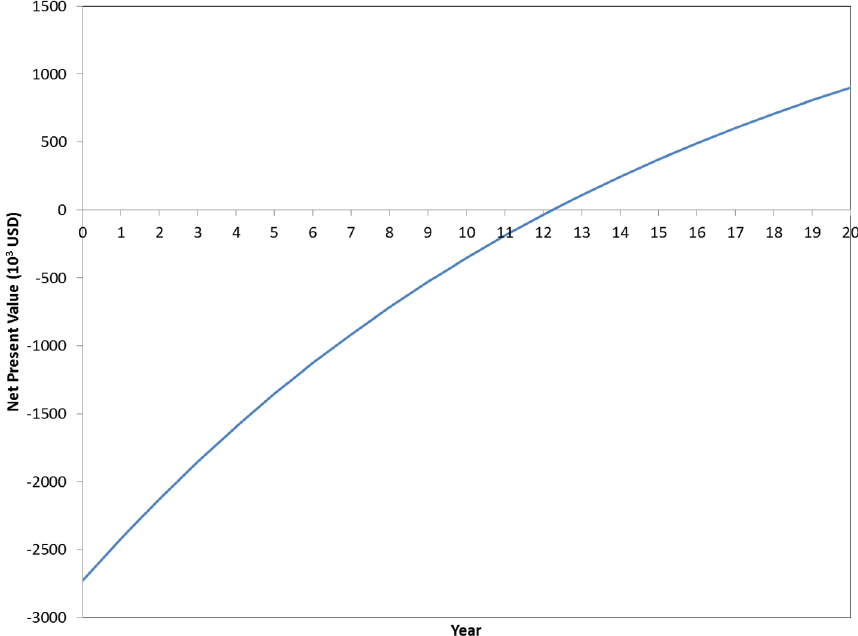
Figure 6. Net present values of the floating photovoltaic system. Table 7. Results of economic and greenhouse gas reduction analyses for the floating photovoltaic system in the study site.